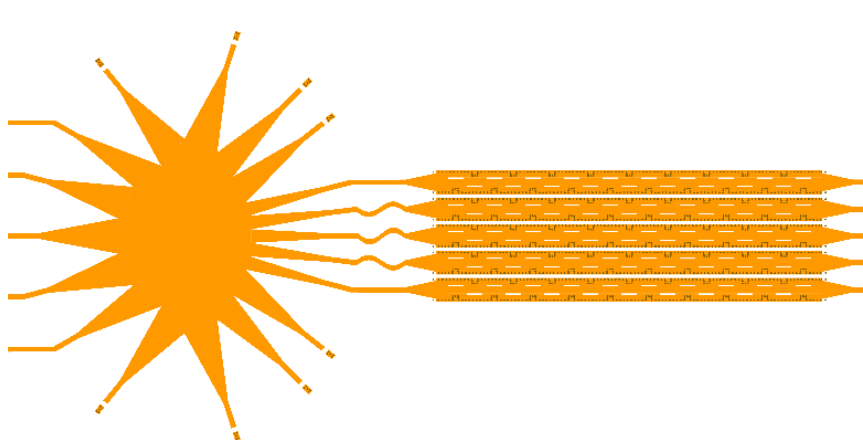
Figure 7. The overall structure of 2D-MBA.